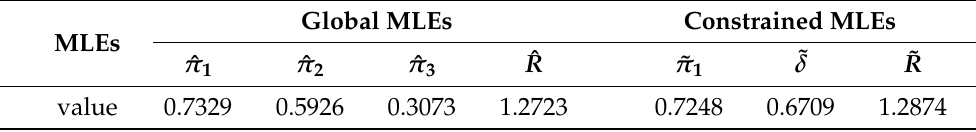
Table 8. Global MLEs and Constrained MLEs.